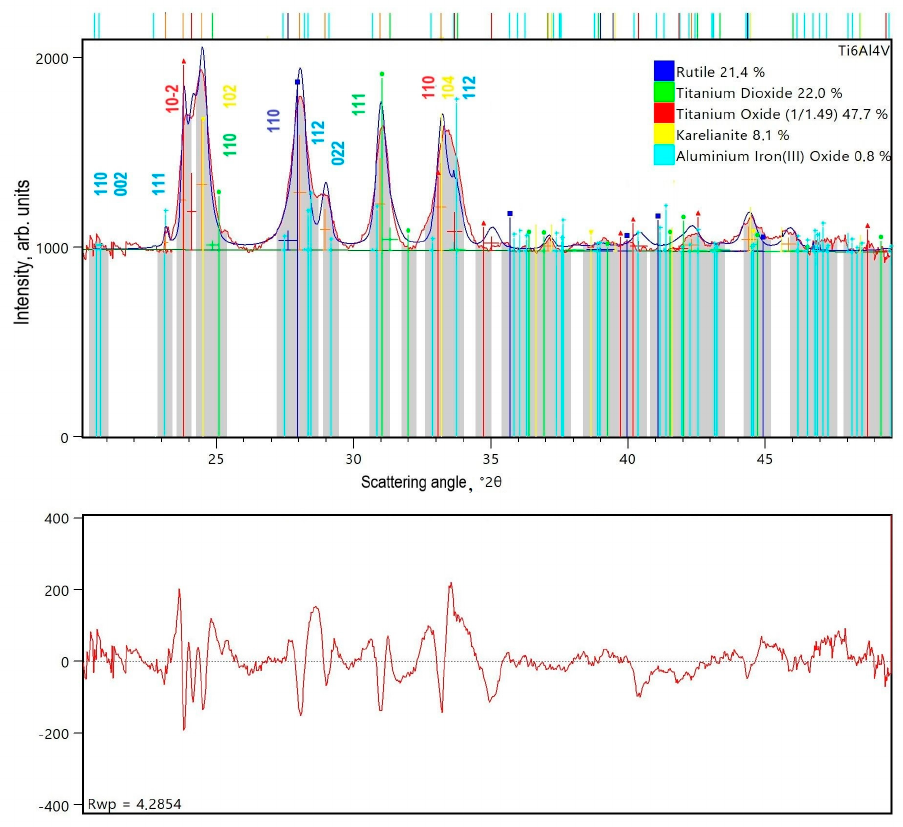
Figure 8. Room temperature X-ray powder diagrams experimental (red solid line), calculated (blue solid line), and the residual one (panel below) for the friction products of Ti6Al4V alloy.